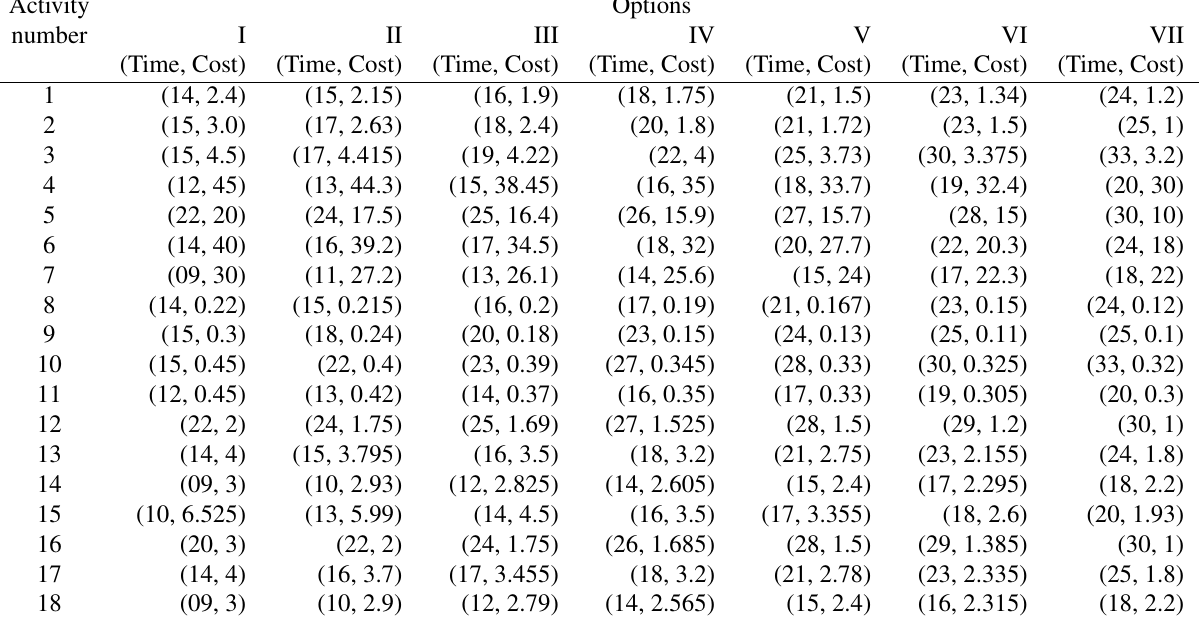
Table 2. Network data of second case study